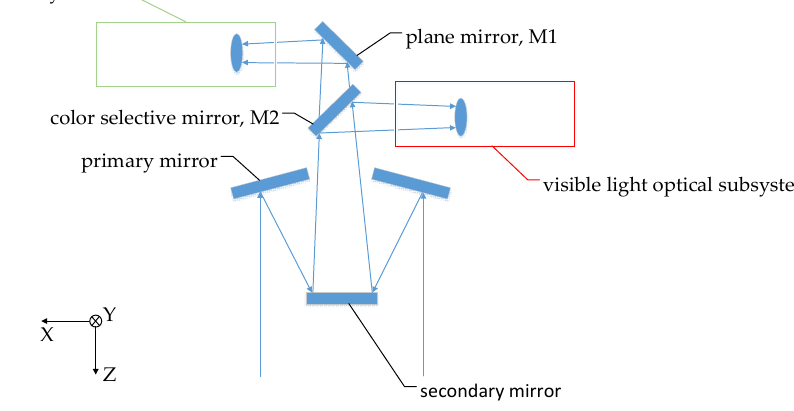
Figure 2. Schematic diagram of optical system.